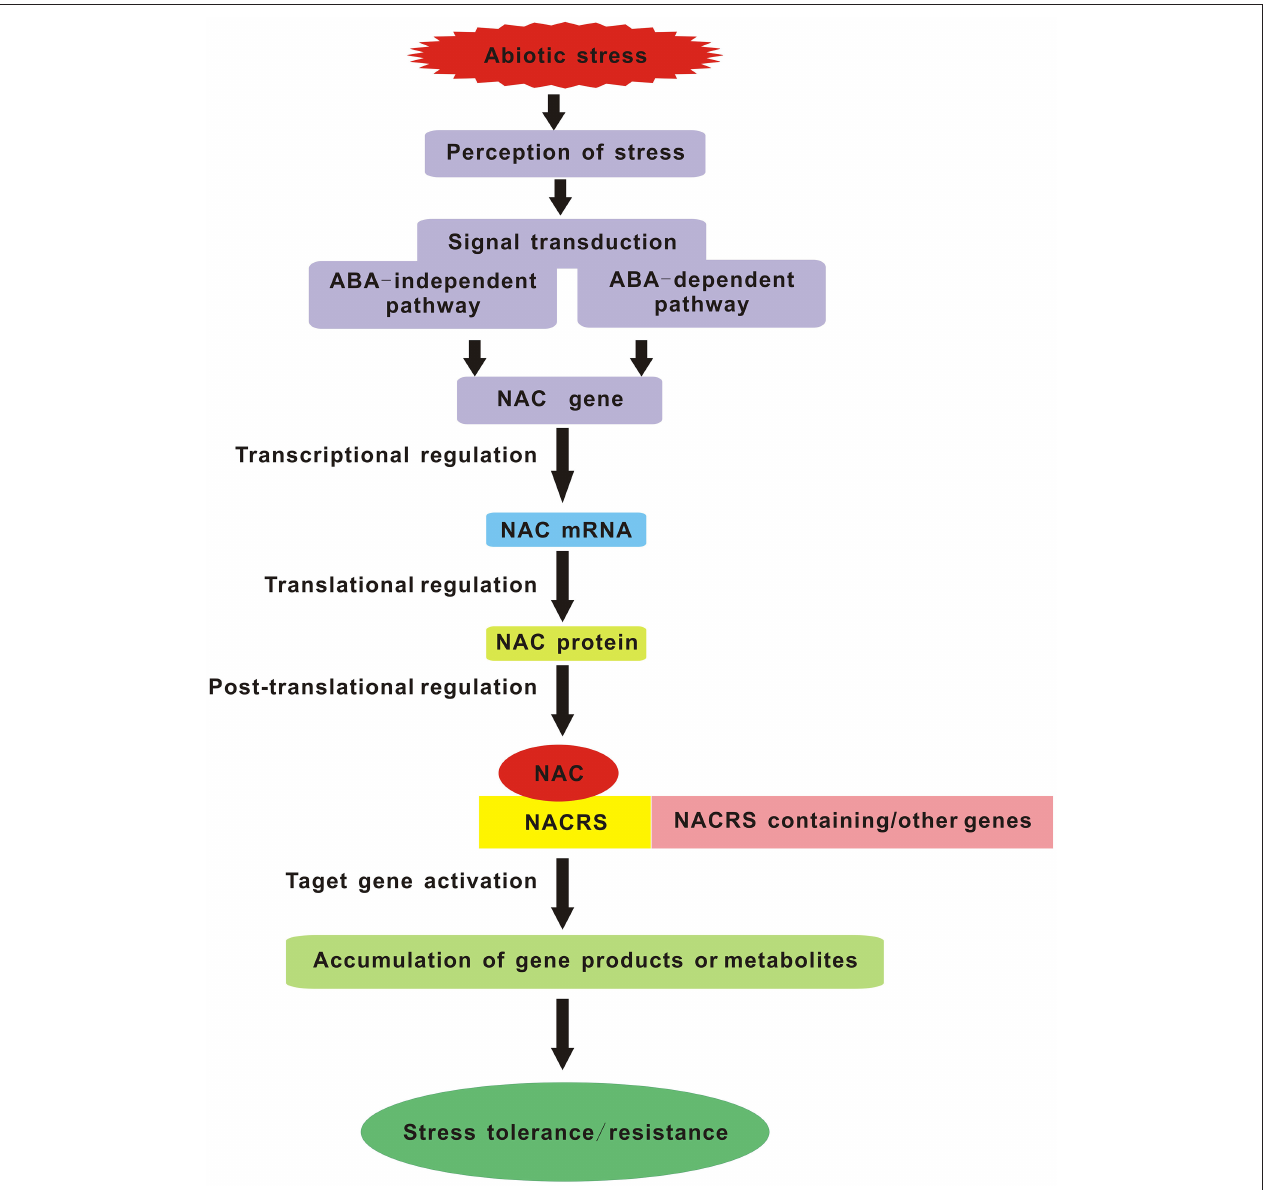
FIGURE 1 | Schematic diagram of NAC TFs as key components in transcriptional regulatory networks during abiotic stress. NACRS is NAC recognition sequence.